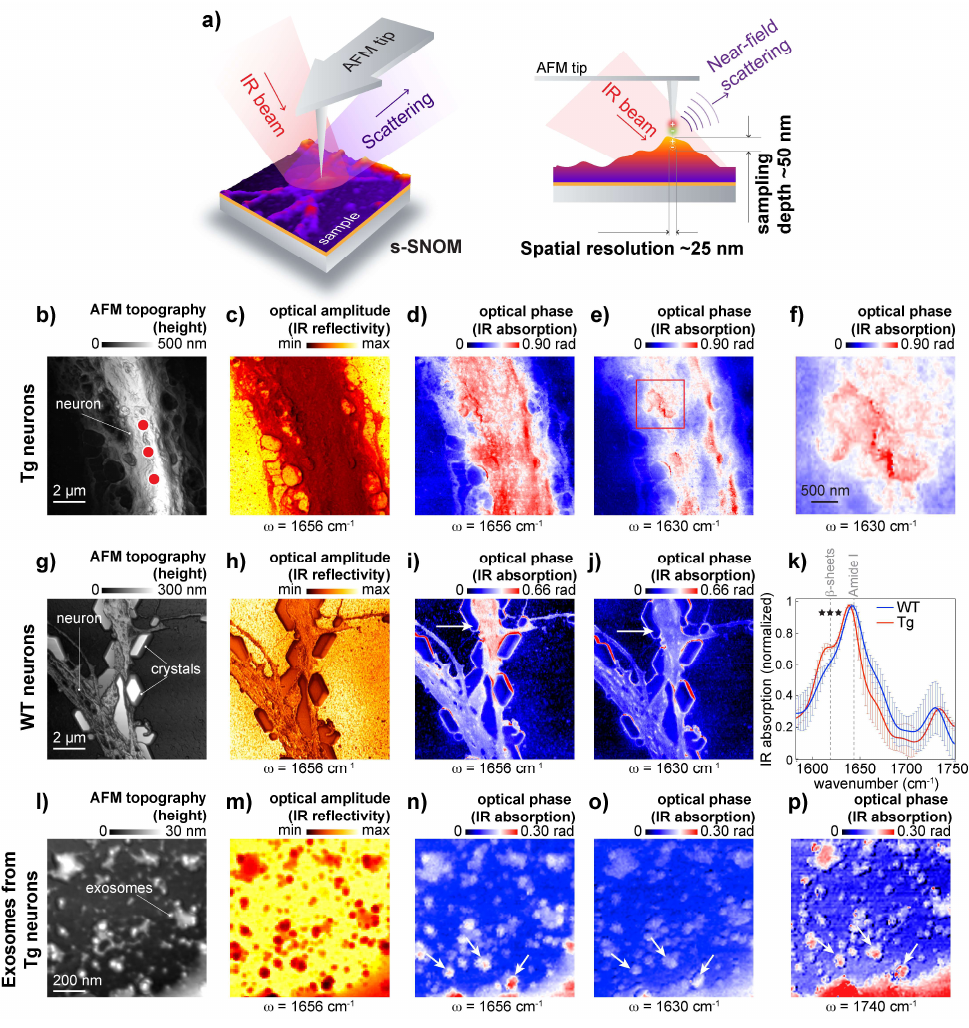
Figure 4. Scattering-type scanning near-field optical microscopy (s-SNOM) nanoimaging and nanospectroscopy. ( a ) Schematic diagram of the working principle, penetration depth, and lateral resolution for s-SNOM. In s-SNOM, a metallic AFM tip acts as an antenna for the incident IR radiation, whose scattering carries local information (or dielectric response) of the material’s surface (left panel). The tip-confined fields in s-SNOM are strongly attached to the metallic tip (evanescent fields); therefore, both lateral resolution and sampling depth are comparable to the tip radius: in this case, their values are ~25 nm and ~50 nm, respectively. ( b – f ) s-SNOM measurements of individual APP/PS1 transgenic neurons cultured on the AFM substrate: 10 × 10 µ m 2 AFM topography map of individual neurons with the dots indicating representative locations for spectra acquisition. The topography amps are followed by corresponding reflectivity and optical phase (IR absorption) images acquired at 1656 cm − 1 , 1630 cm − 1 , and digital zoom-in of the area indicated by the red square in 1630 cm − 1 optical phase image to show amyloid patches on neuronal surface. ( g – j ) s-SNOM measurements of wild-type neurons cultured on the AFM substrate: 10 × 10 µ m 2 AFM topography map of individual neurons, followed by the corresponding reflectivity image and optical phase (IR absorption) images acquired at 1656 cm − 1 and 1630 cm − 1 . ( k ) Averaged and normalized s-SNOM nano-FTIR broadband spectra recorded from wild-type (blue) and APP/PS1 transgenic neurons (red). Vertical dashed lines indicate spectral shoulders at around 1656 cm − 1 , 1630 cm − 1 , and 1740 cm − 1 . Each point spectrum is an average of 15–30 spectral scans. Error bars show standard deviation. s-SNOM spectra were acquired from different neurons (3 to 5 cells per genotype, using at least 3 independent preparations of neuronal cultures). Statistics: a paired t-test for comparing two groups; *** correspond to p < 0.001. ( l – p ) s-SNOM measurements of exosomes isolated from cultured APP/PS1 transgenic primary neurons: 1 × 1 µ m 2 AFM topography map of exosomes deposited on AFM substrate, followed by the corresponding reflectivity image and optical phase (IR absorption) images acquired at 1656 cm − 1 , 1630 cm − 1 , and 1740 cm − 1 . White arrows indicate lipid–protein-rich spots that were identified as